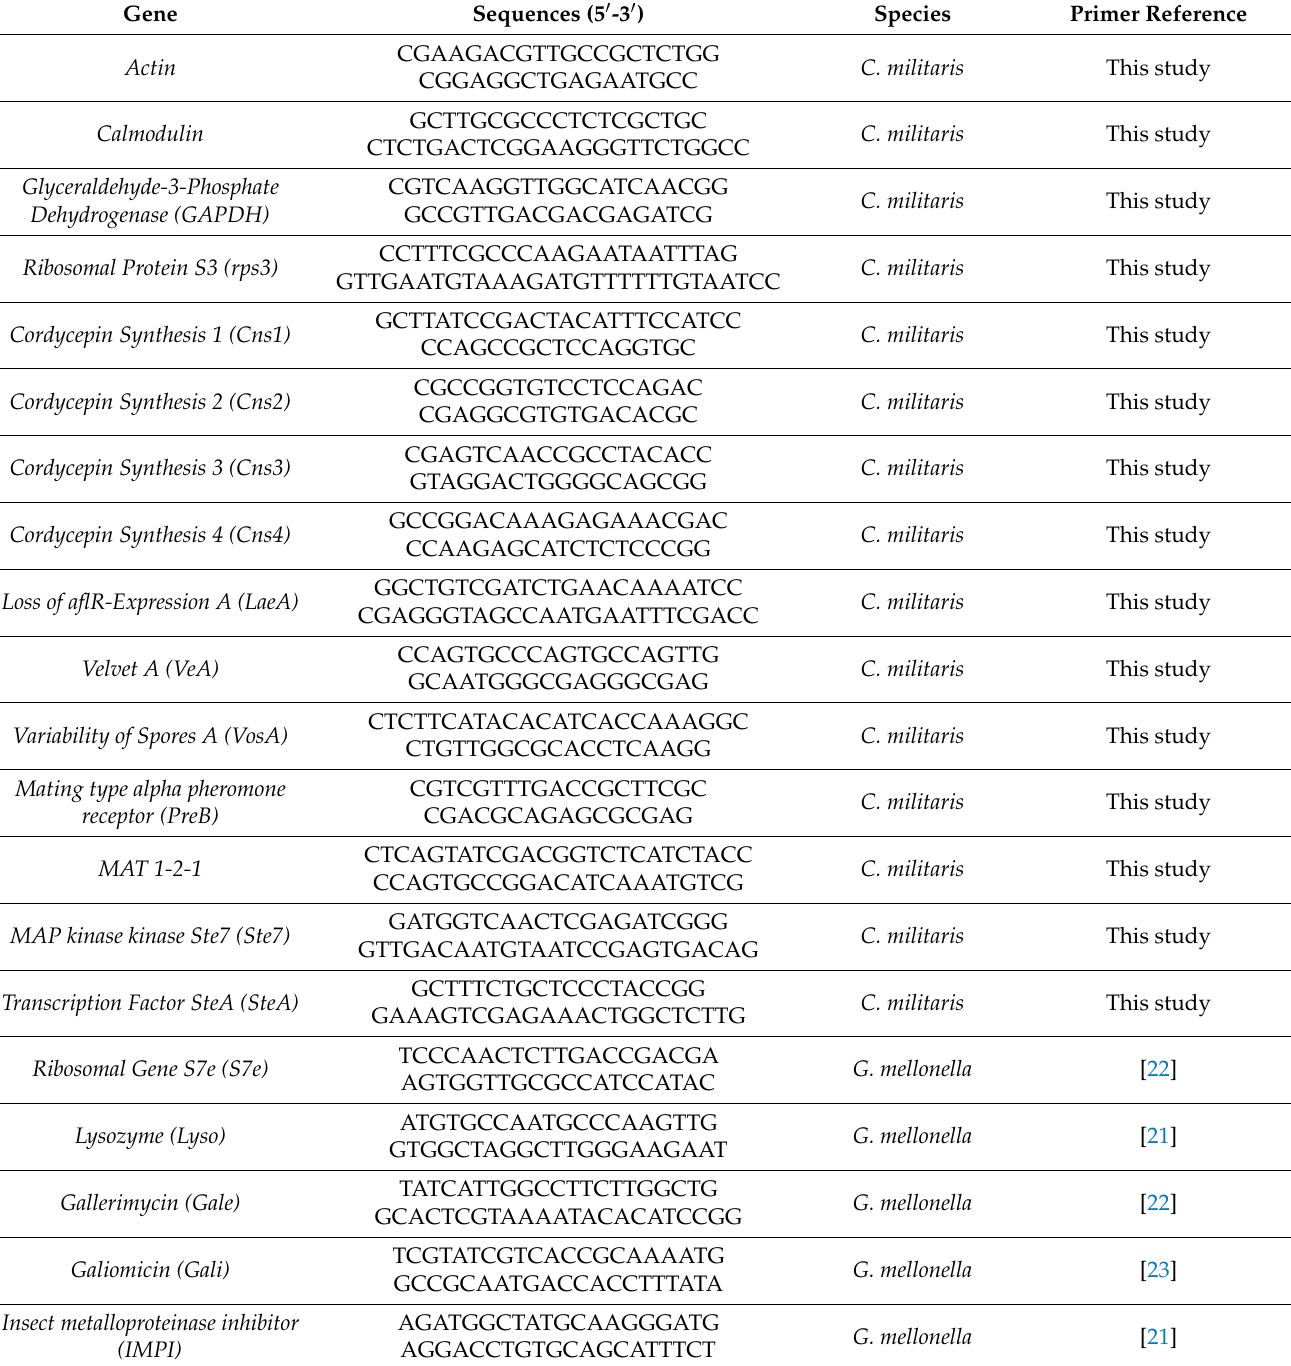
Table 1. Primers used in RT-qPCR analyses, to assess changes in gene expression from both, Cordyceps militaris and Galleria mellonella